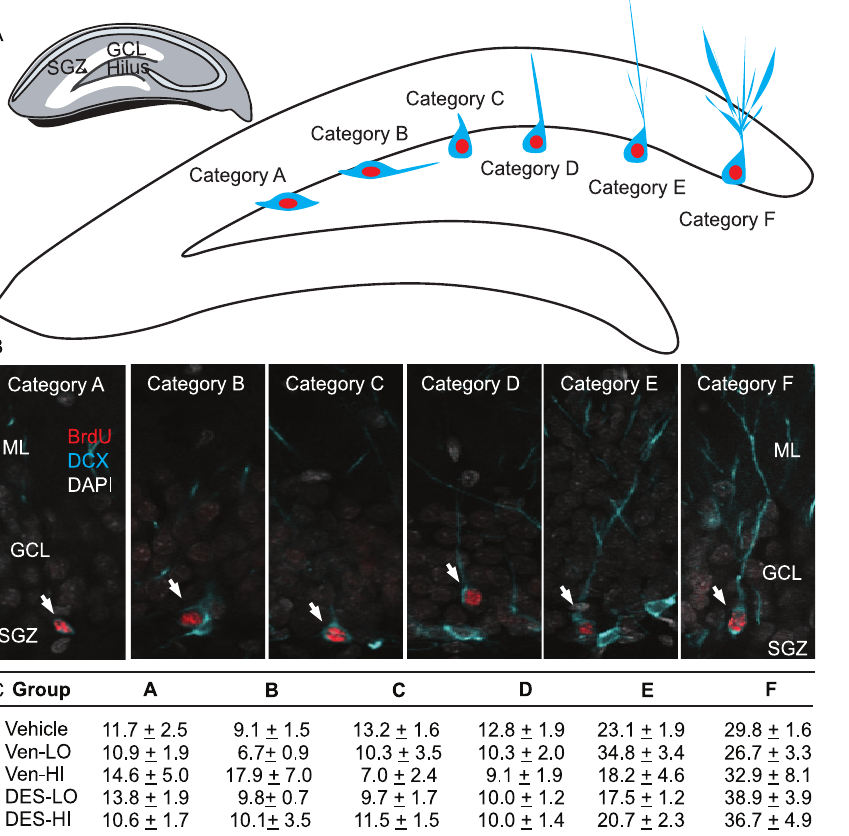
Figure 5. Anti-depressant treatment does not influence the maturation of DCX + neurons found throughout the dentate gyri of adult male rats. A ) Schematic of the hippocampus proper and dentate gyrus (small cartoon on left) containing the granule cell layer (GCL), subgranular zone (SGZ) where neural progenitor cells divide and hilus. The larger schematic on the right depicts the GCL and hilus of the dentate gyrus with examples of BrdU/DCX + cells classified as Category A-F based upon their dendritic morphologies and extension through the GCL. Note that immature neurons found throughout the infra- and supra-pyramidal blades of the granule cell layer were categorized. This categorization has been used previously to estimate the maturity of DCX + neurons. B ) Representative confocal images of 10 to 14 day-old BrdU + cells (in red) that express DCX (in cyan) and that have been classified as Category A-F based upon their dendritic morphology and extension through the GCL. Cell nuclei are labeled with DAPI (in gray) and grouped into 6 categories (A to F) with all cell nuclei visualized using DAPI (gray) and the GCL can be visualized in each panel. C ) Regardless of treatment group, the majority of 10 to 14 day-old BrdU/DCX + neurons were classified as Category E or F and treatment did not impact Categorization.